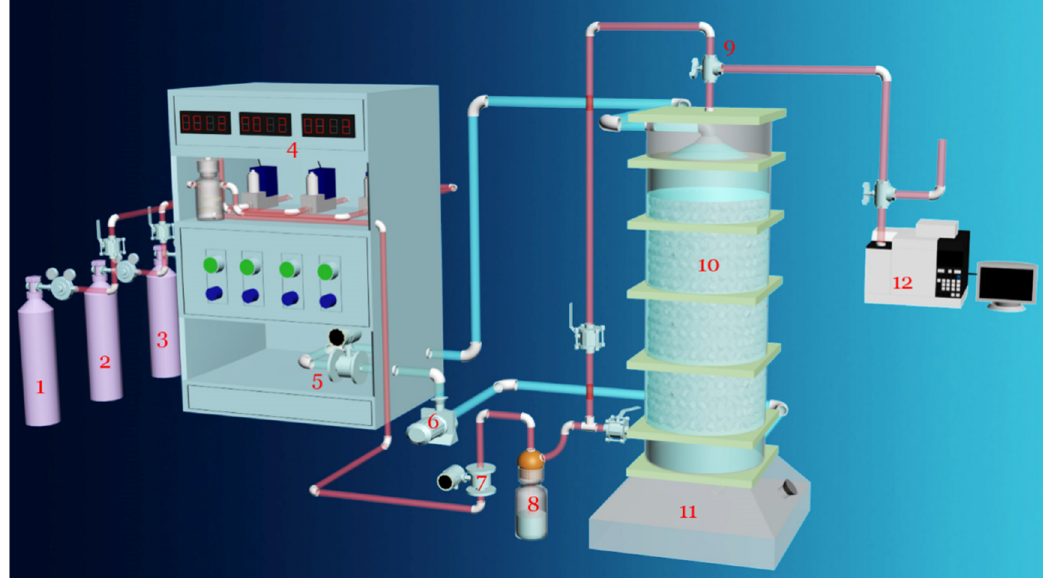
Figure 1. Schematic diagram of the bio-trickling filter: 1. N 2 ; 2. O 2 ; 3. CO 2 ; 4. Gas flowmeter; 5. Fluid flowmeter; 6. Circulating water pump; 7. Gas flowmeter; 8. Chlorobenzene; 9. Valve; 10. BTF; 11. Water tank; 12. Gas chromatography.